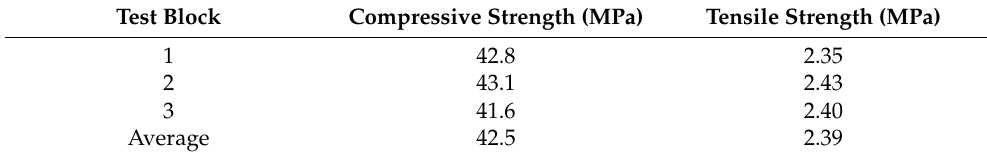
Figure 8. Connection structure diagram of EREDL. Table 3. Axial tensile strength and axial compressive strength of concrete.